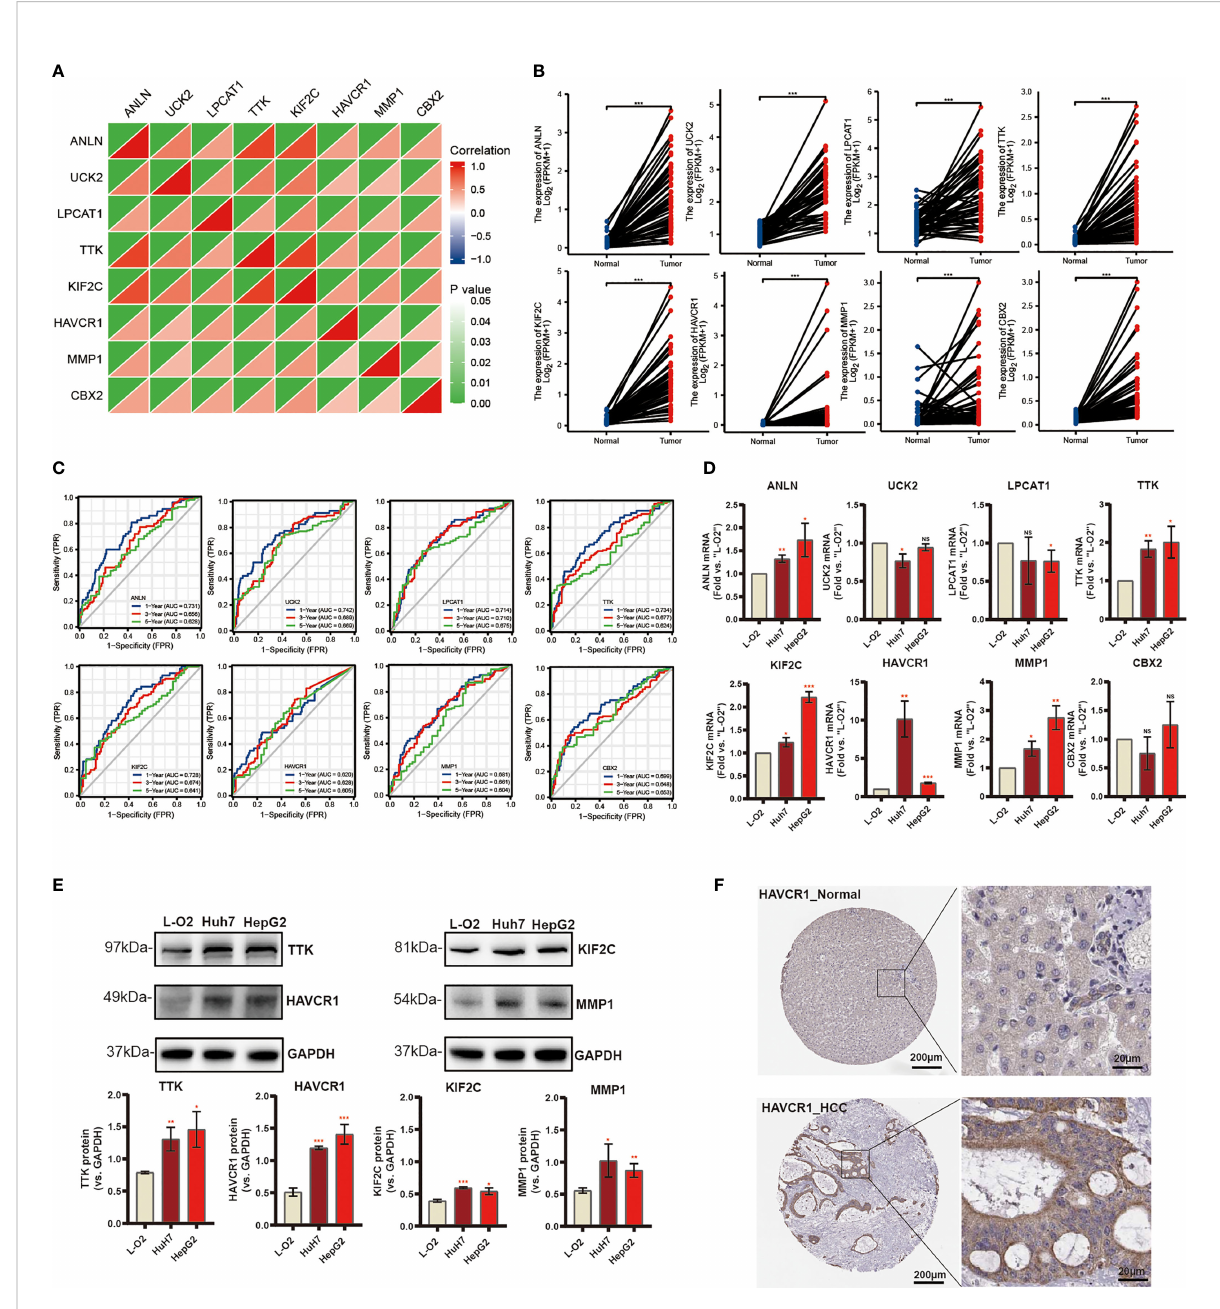
FIGURE 7 Differential Expression of Independent Prognostic Genes and Validation. (A) Spearman correlation analysis of eight candidate genes in the TCGA-LIHC cohort. (B) Eight risk genes expression in paired tissues from TCGA database. (C) The ROC curve of independent risk genes in TCGA-LIHC cohort. (D) The mRNA levels of quanti fi ed using qRT-PCR analysis in human liver cell line and two HCC cell lines. (E) The protein expression of TTK, KIF2C, HAVCR1, and MMP1. (F) Immunohistochemistry of the HAVCR1 from the HPA database (*p < 0.05, **p < 0.01, ***p <